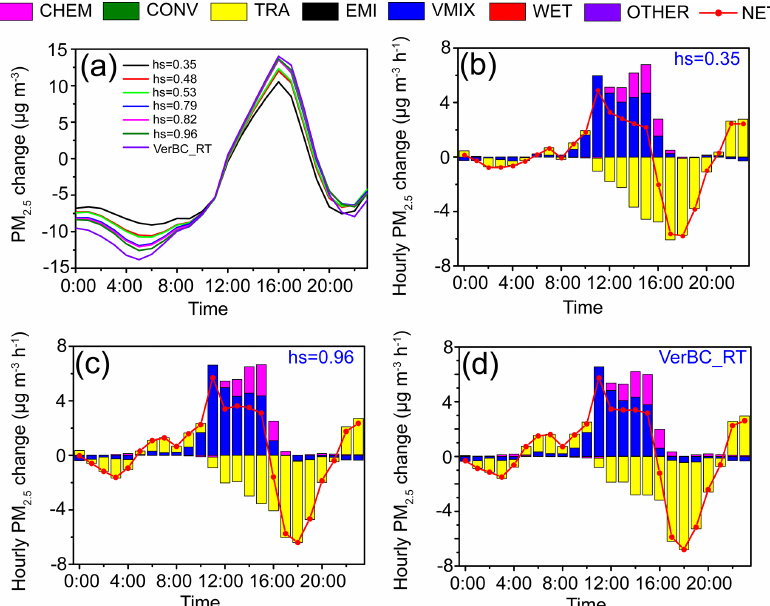
Figure 14. (a) Time series of the changes in surface layer PM 2 . 5 in Beijing caused by BC with six exponential functions (VerBC_hs1-6 minus NoBCrad) and one observed transport-dominated vertical profile (VerBC_RT minus NoBCrad) averaged for 12 and 16–19 December 2016. (b–d) The hourly contributions of each physical and chemical process to PM 2 . 5 changes caused by BC DRE with two exponential functions (hs = 0.35 and 0.96) and one transport-dominated vertical